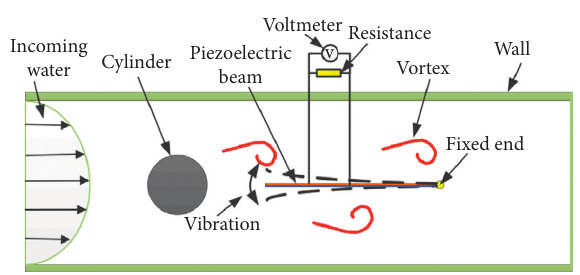
Figure 11: Schematic of the piezoelectric harvester downstream of a bluff body [107].